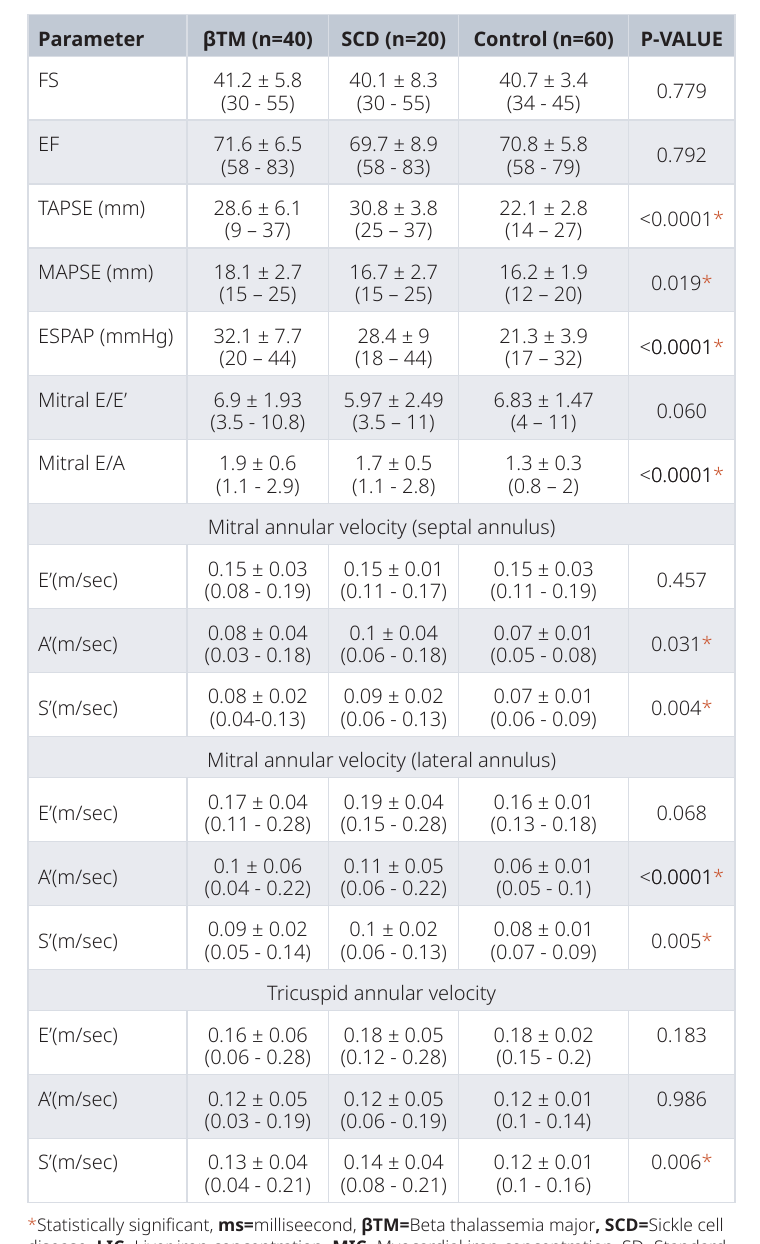
Table 2. Echocardiographic and Tissue Doppler Imaging data of the studied patients and controls. Data are expressed as mean±SD